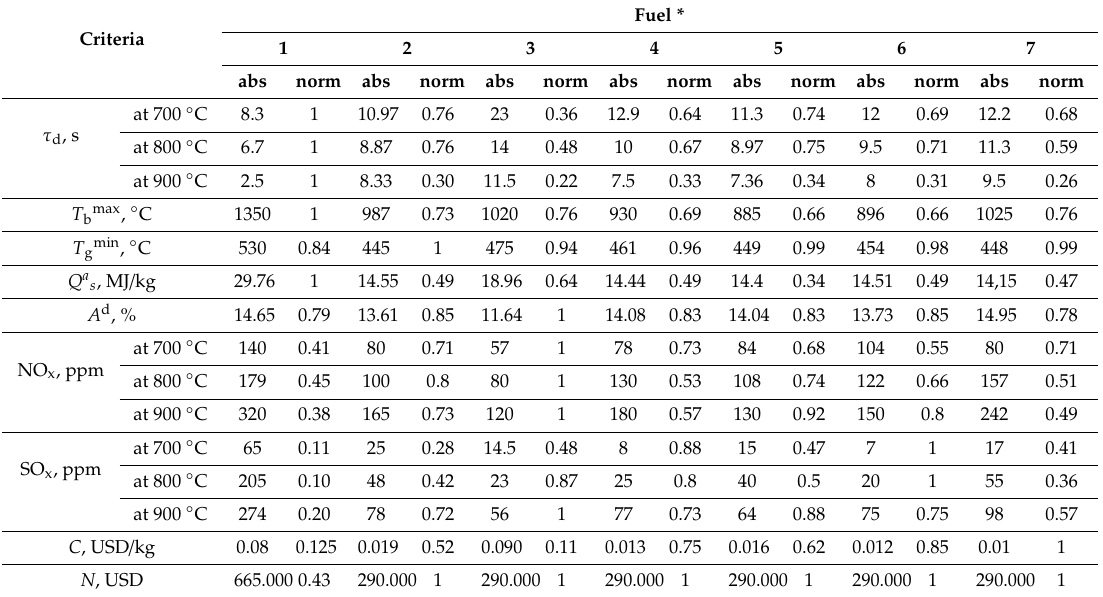
Table 5. Absolute (abs) and normalized (norm) fuel e ffi ciency evaluation criteria for WSM method.